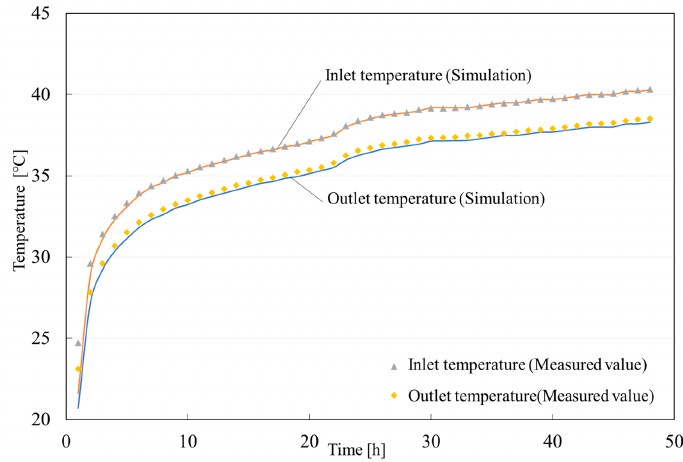
Figure 4. Comparison of temperature variations of GHE inlet/outlet.